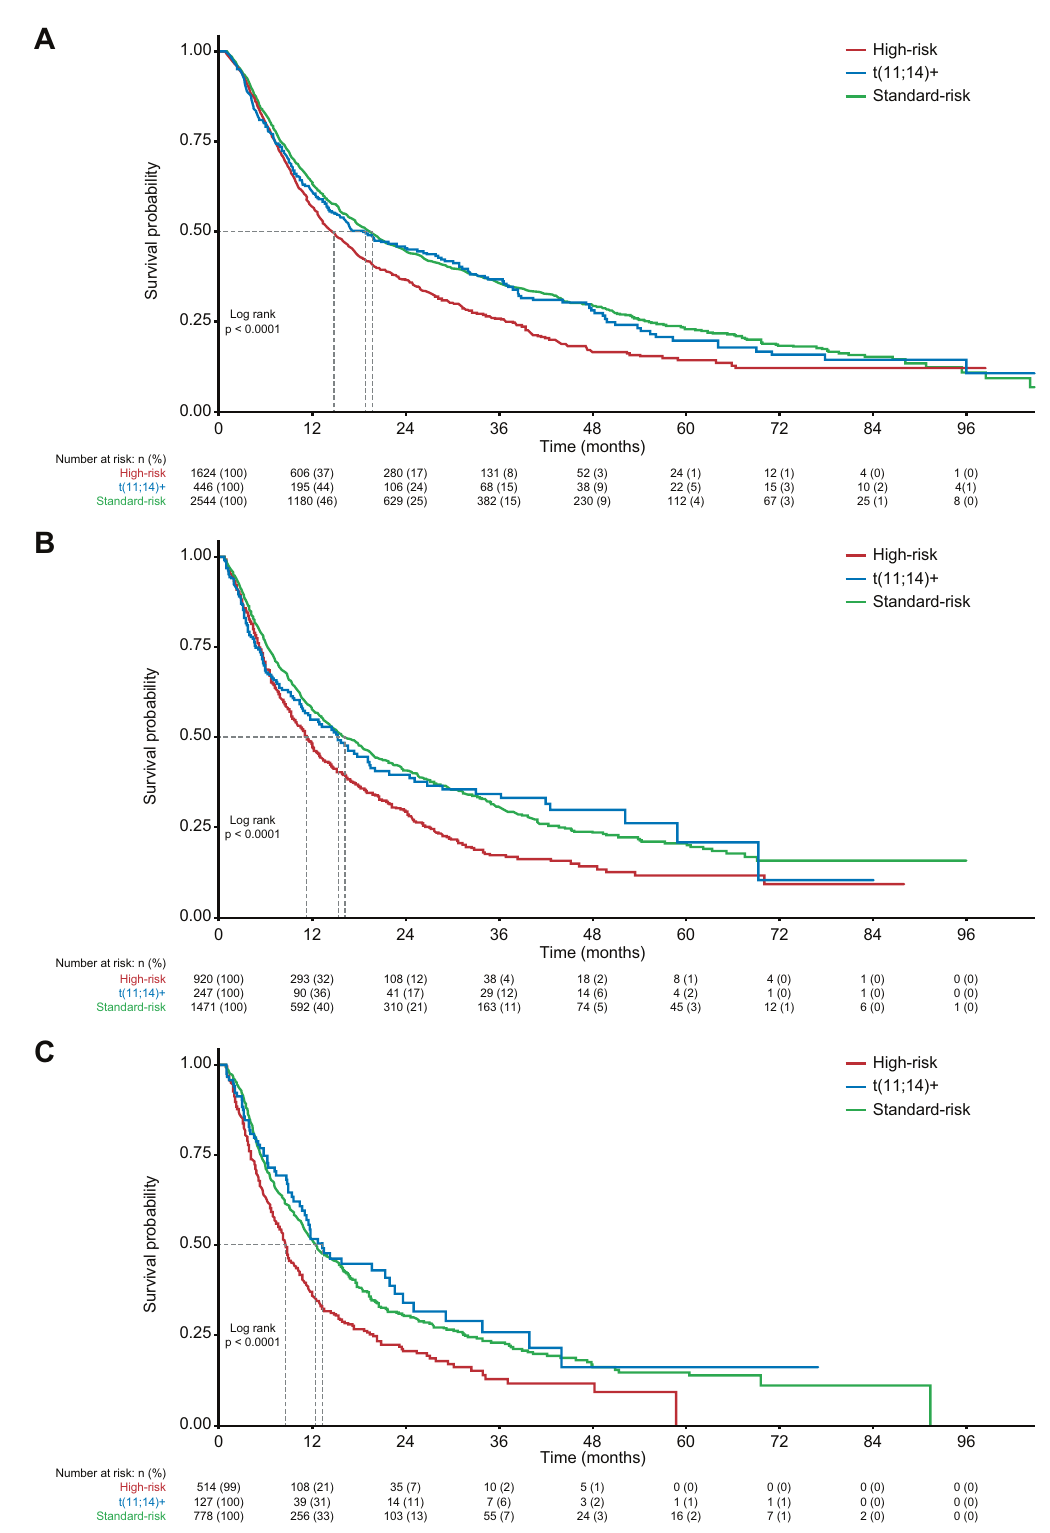
Fig. 3 Kaplan – Meier curves for TTNT by patient risk subgroup. First-line ( A ), second-line ( B ), and third-line ( C ) therapy. t translocation, TTNT time to next for treatment regimens for relapsed/refractory MM, thus shifting the treatment paradigm. As the present study includes patients treated between January 1, 2011 and February 29, 2020, all treatments